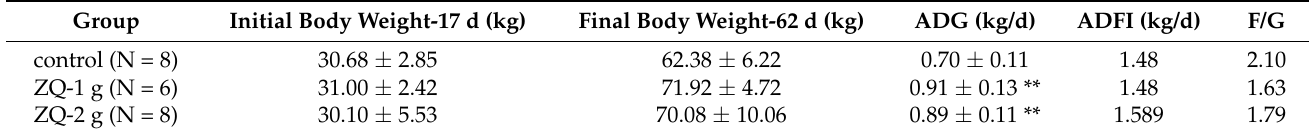
Figure 3. Effects of ZQ on ADG of pigs. ( a ) ADG at the nursery phase. ( b ) ADG at the finishing phase. * Indicates p < 0.05 and ** indicates p < 0.01 between the treatment group (ZQ-1 g or ZQ-2 g) and the control group. Table 2. Growth performance at the finishing